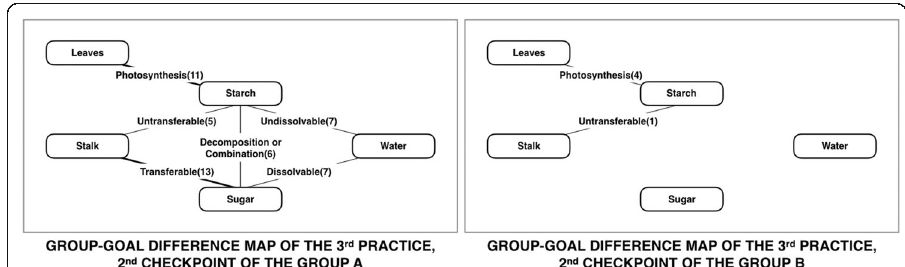
Fig. 12 The group-goal difference map of the third